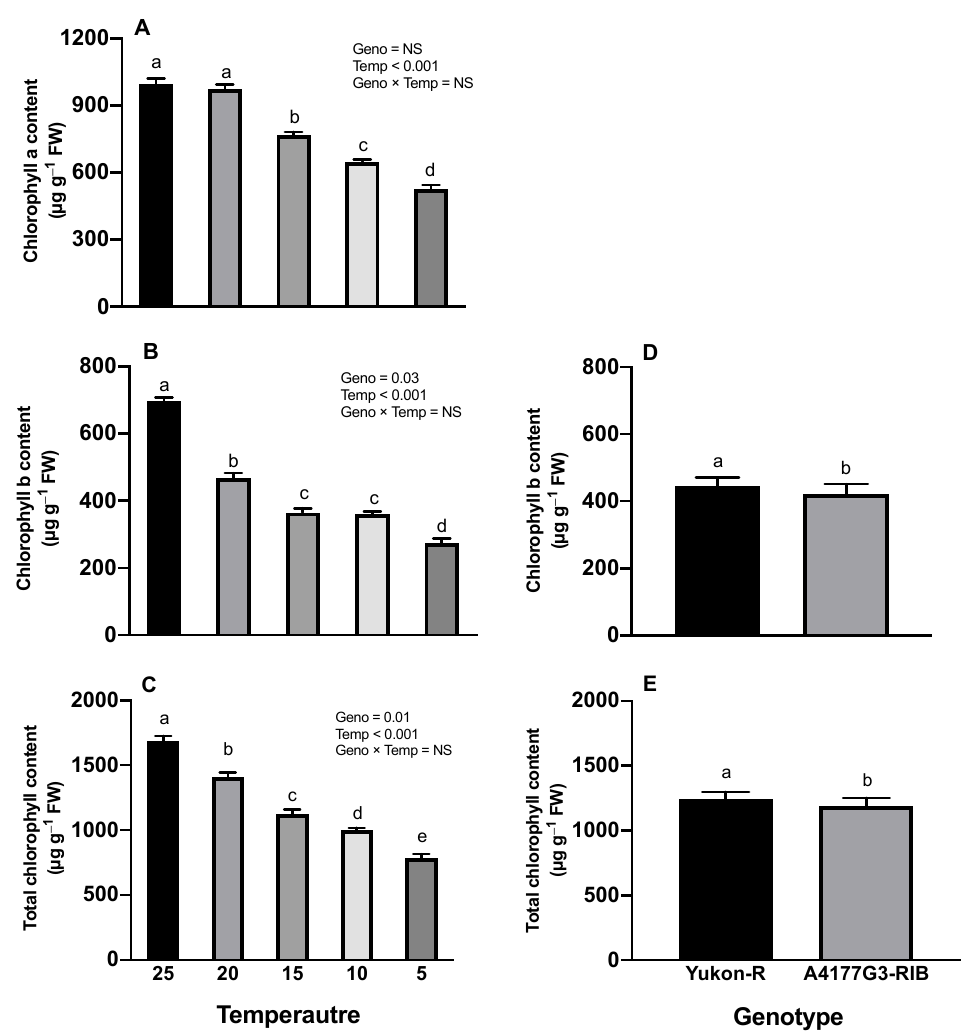
Figure 2. Effects of temperature regime on leaf chlorophyll ( A ), chlorophyll b ( B ), and total chlorophyll content ( C ) of silage corn genotypes; the response of silage corn genotypes to chlorophyll b content ( D ) and total chlorophyll content ( E ). Each vertical bar represents the average of replicates ± SE of the mean ( n = 30 for Geno, n = 12 for Temp, n = 6 for Geno × Temp). Different letters indicate significant differences among treatments at p ≤ 0.05 according to Fisher’s Least Significant test. Geno = genotype; Temp =